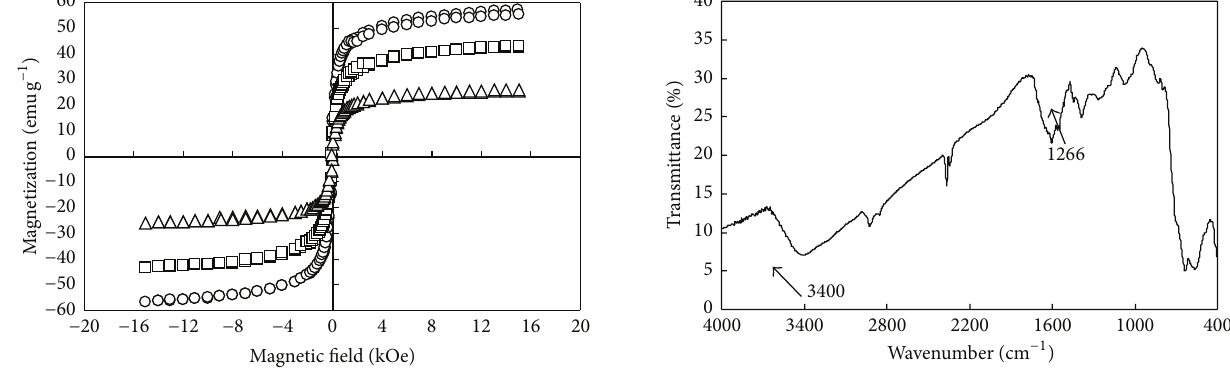
Figure 1: Magnetization curves of various magnetic particles. [ CH ( OH )] I , ◻ , and △ : Fe 3 O 4 , PVAL: 2 CH 𝑛 , and PVAC: ( OCOCH )] [ CH 2 CH 3 𝑛 .